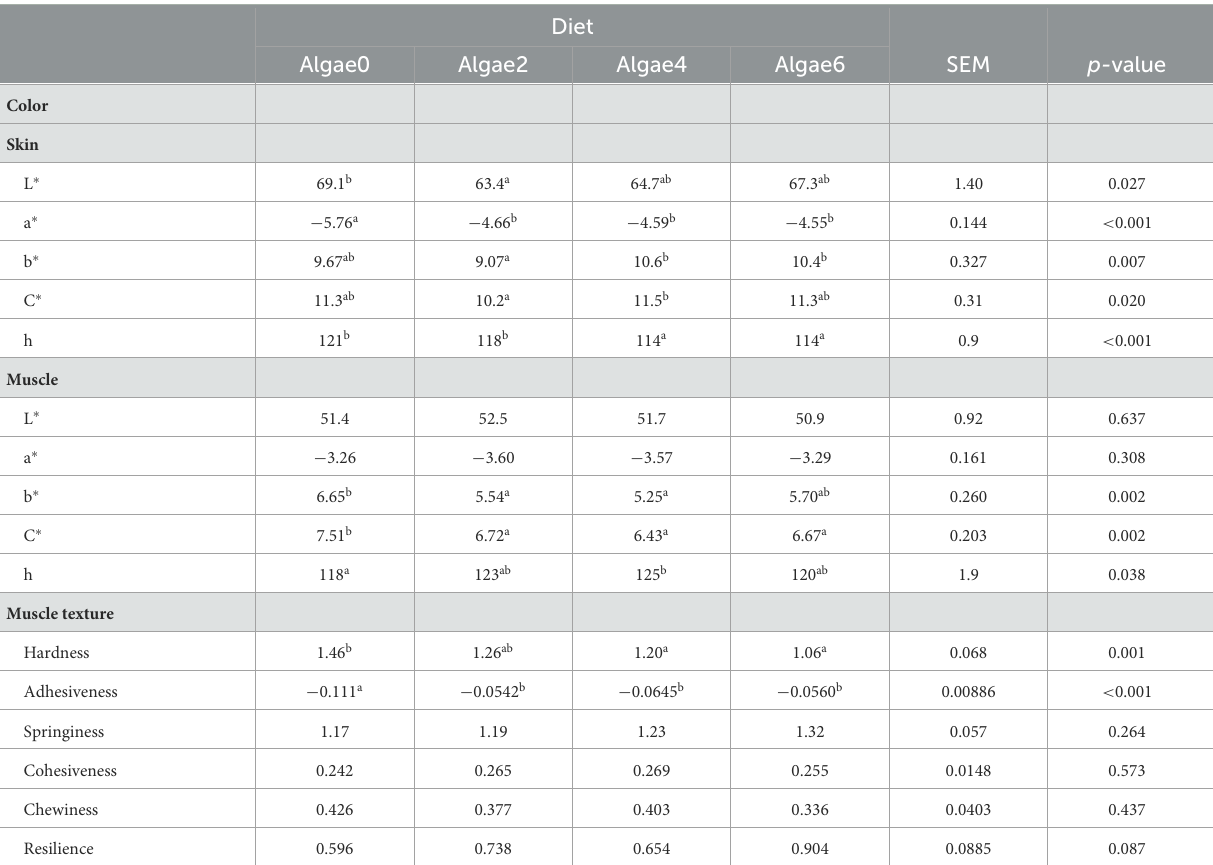
TABLE 8 Skin and muscle color and muscle texture of European seabass juveniles fed the experimental diets. Diet Algae0 Algae2 Algae4 Algae6 SEM p-